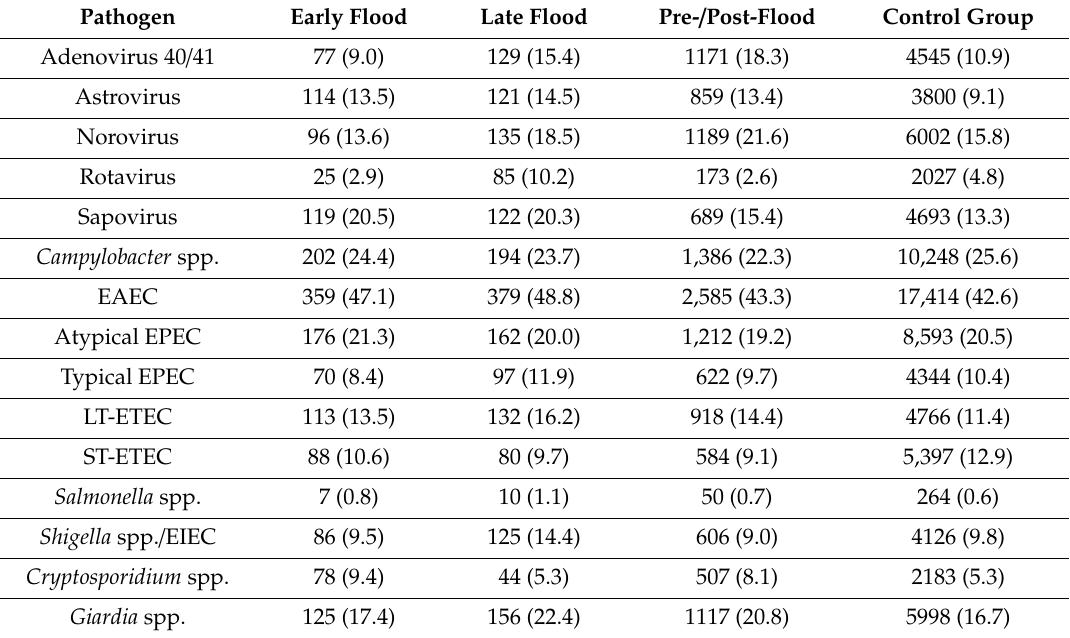
Table 1. Number and percentages (%) of stool samples that were positive for di ff erent species of enteropathogens in the MAL-ED Peru site during three periods relative to the flood and in the other seven study sites (control group)